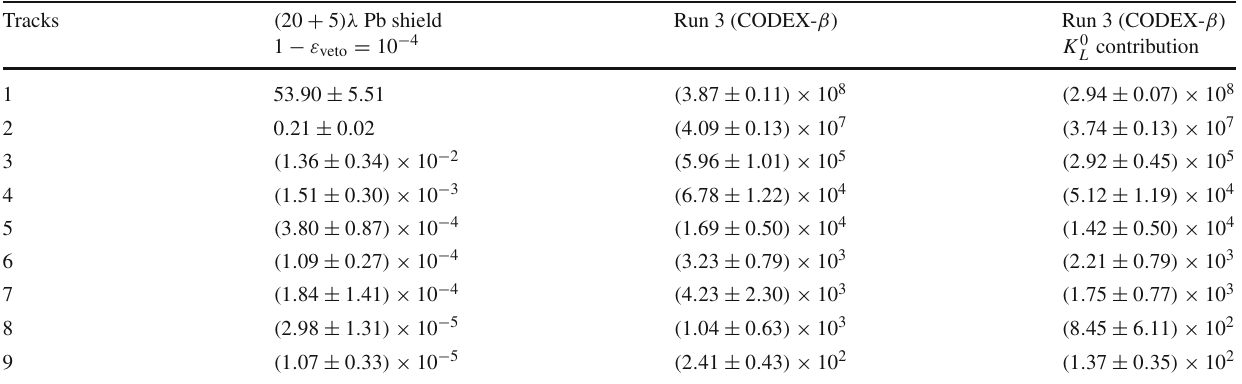
Table 3 Multitrack production on air from the Geant4 background simulation for the ( 20 + 5 )λ Pb shield, in the 10 × 10 × 10m 3 detector volume for total luminosity L = 300fb − 1 , requiring E kin > 0 . 4GeV